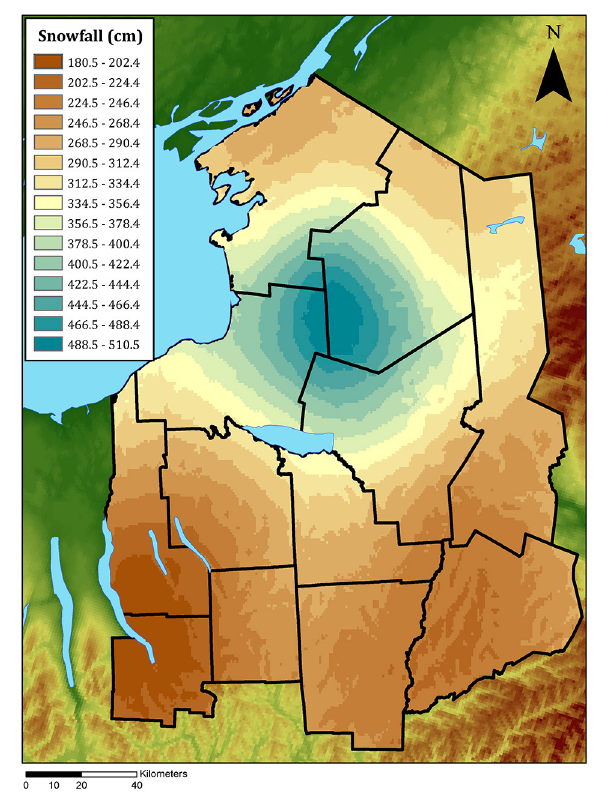
FIGURE 3 | Average seasonal snowfall totals (cm) for Central New York from 1995/96 to